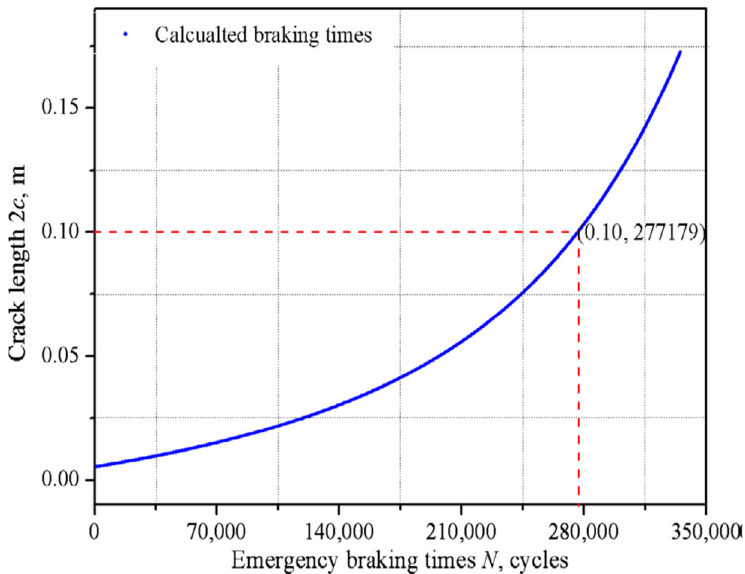
Figure 17. Expected crack length depending on the number of emergency braking cycles performed; the limit crack length of 100 mm was reached in this case after 277,179 braking cycles [8].